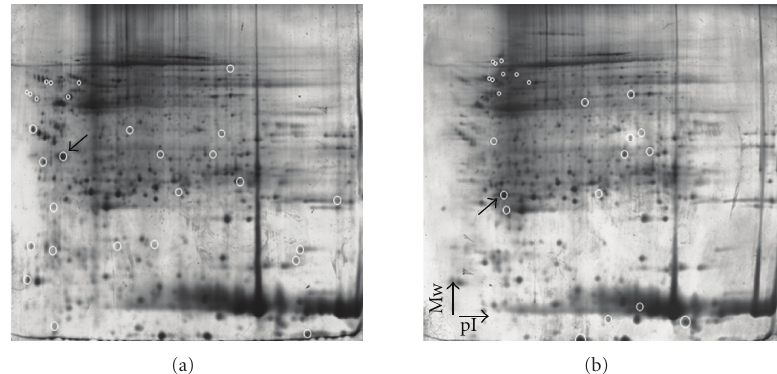
Figure 4: Two-dimensional separation of pooled proteins from normotensive (a) and PE (b). Circles indicate spots whose amount was increased in the 2D-PAGE of normotensive and PE samples analyzed with the Ludesi’s software Redfin. Arrows show identified proteins; see Table 2. The gels were stained with SYPRO Ruby.